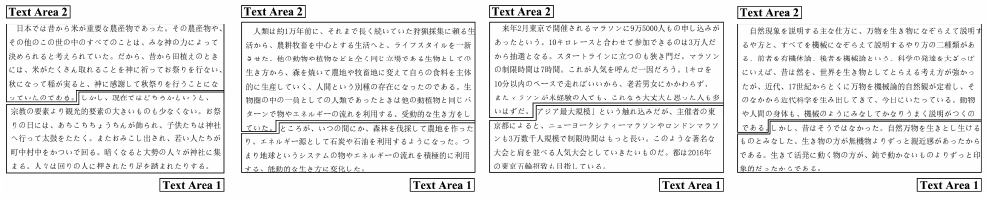
Figure 6. Text Areas 1 and 2 in four Japanese reading articles.